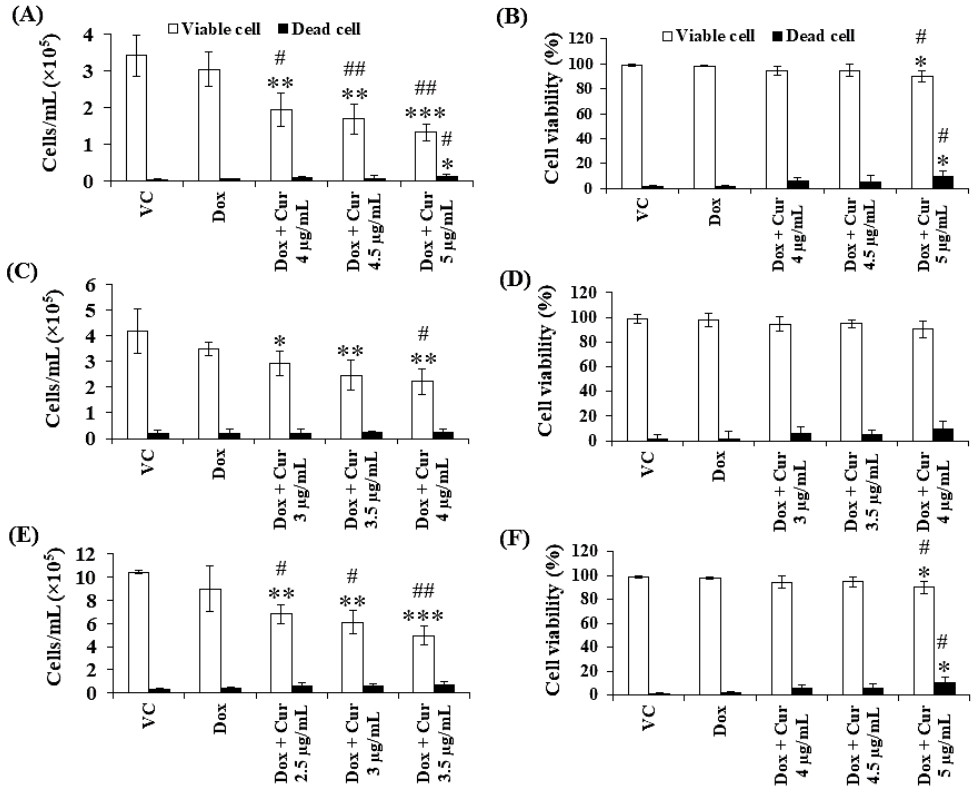
Figure 5. Total cell number and cell viability of KG-1a, KG-1, and EoL-1 cells after treatment with Dox and combination